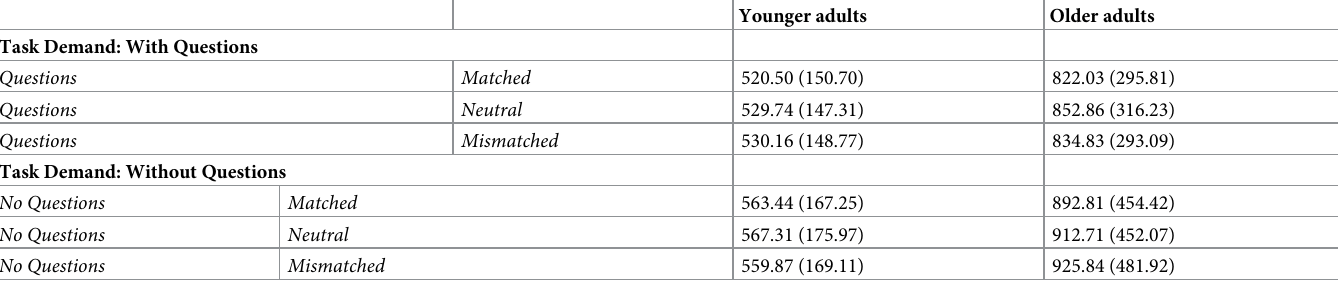
Table 3. Mean reading time (ms) and standard deviation per sentence context in the parts with and without additional questions in each age